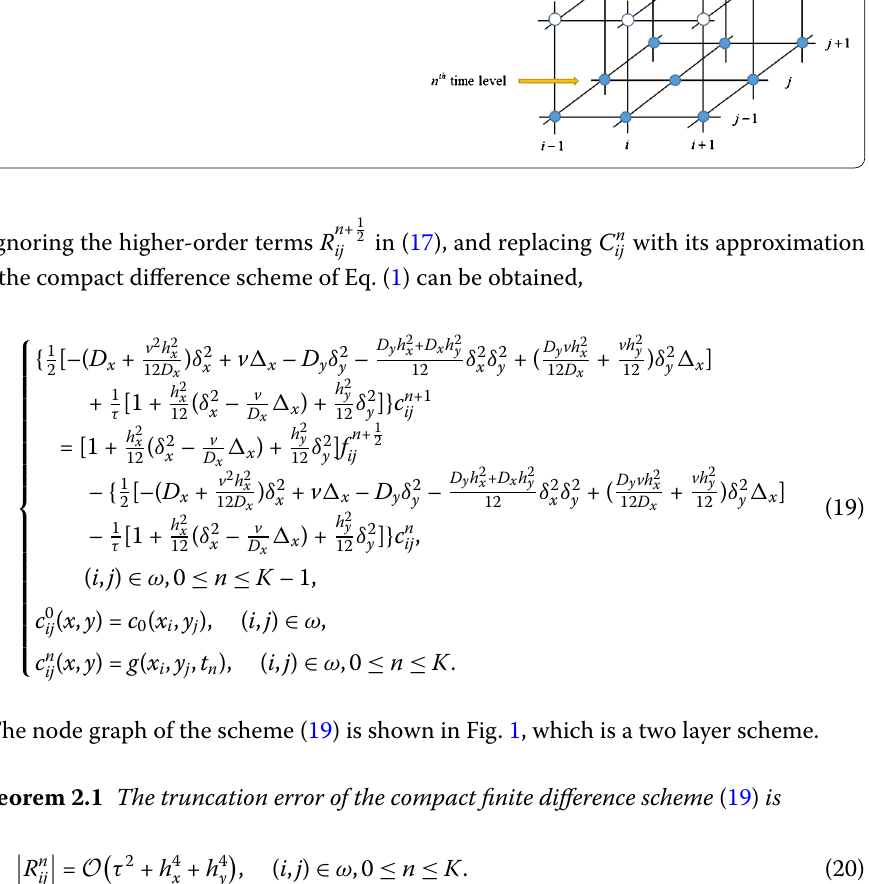
Figure 1 Node distribution graph of the compact difference